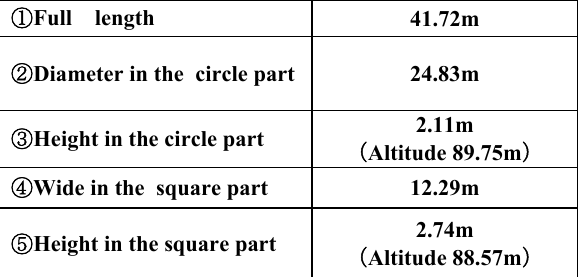
Fig14. Animation by Land-Viewer (RRIM of